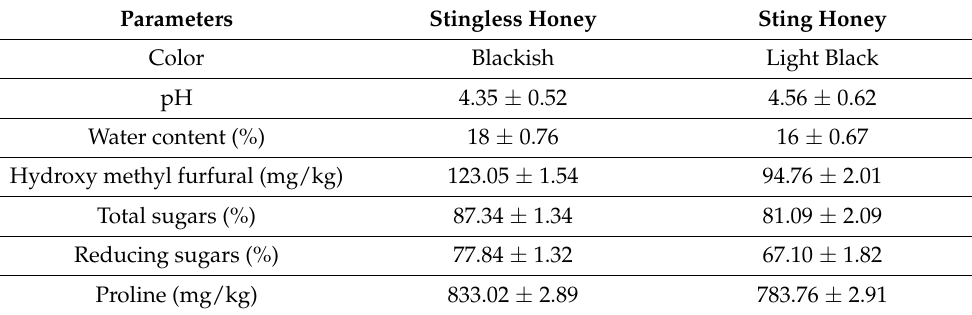
Table 3. The physicochemical parameters of the honey samples.